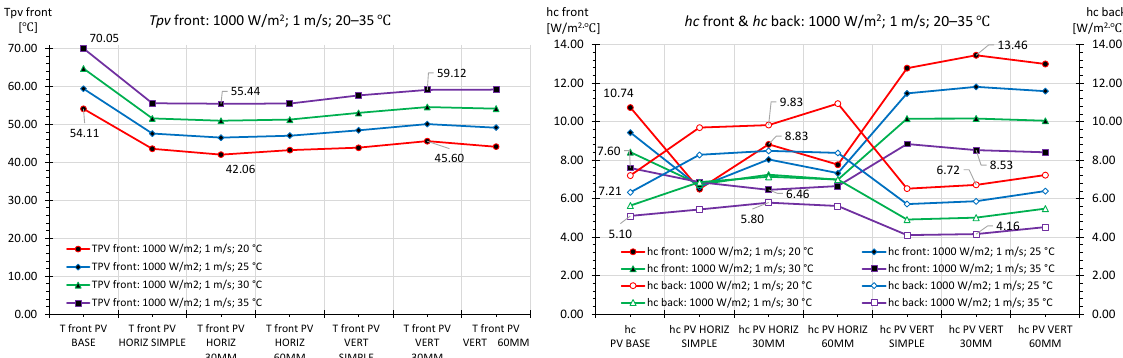
Figure 8. Variation of average operating temperature and convective heat transfer coefficient for studied cases. G = 1000 W/m 2 , v air = 1 m/s and t air = 20–35 °C.